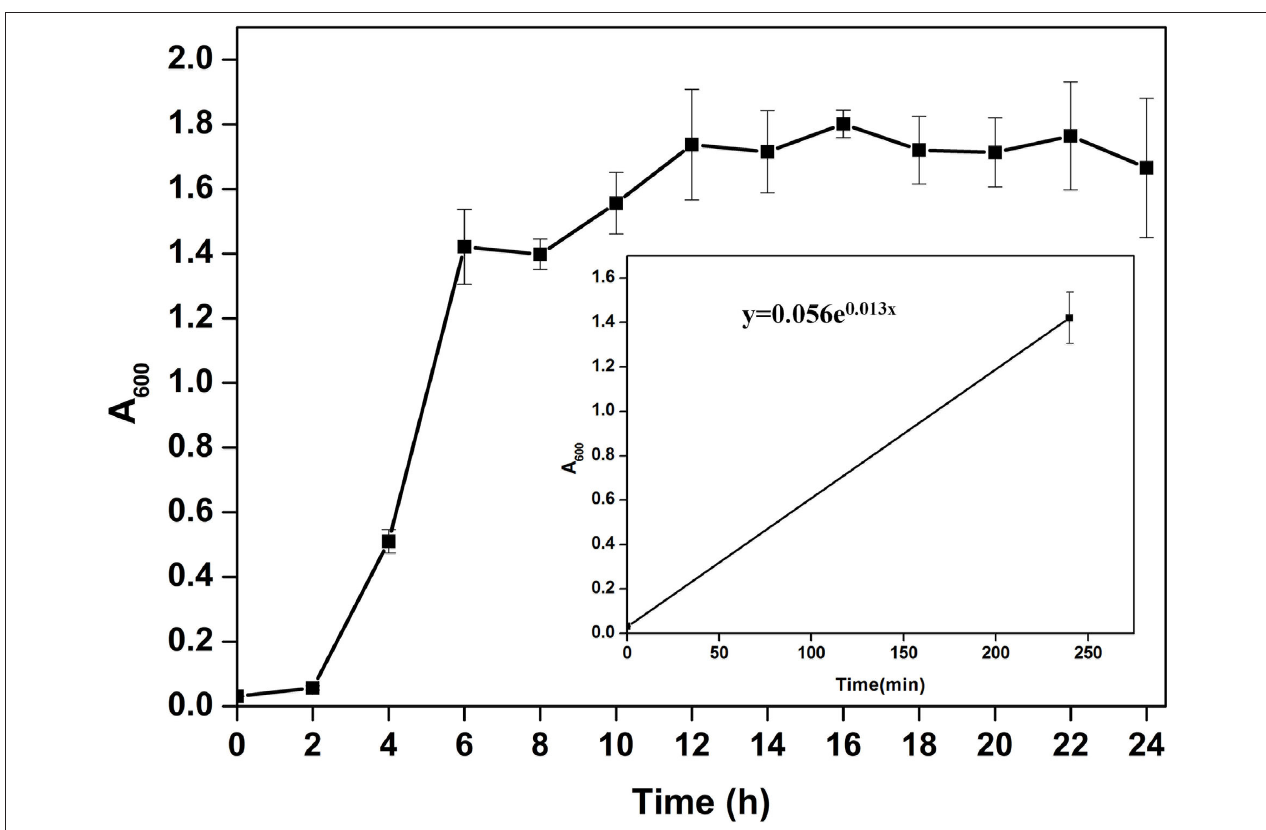
FIGURE 1 | Growth pattern analysis of the bacterial isolate strain NB2 in Luria-Bertani broth for 24h at 37 ◦ C with constant shaking at 200 rpm. Each point in the graph is the mean value of readings observed in triplicate experiments.